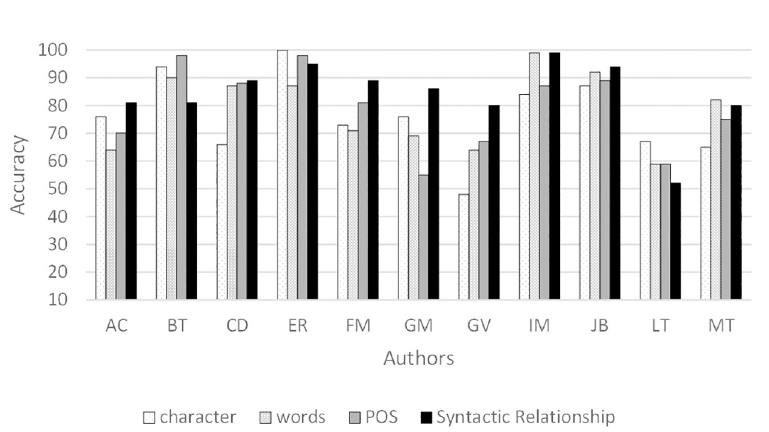
Fig 3. Average accuracy (%) for 3-grams using all